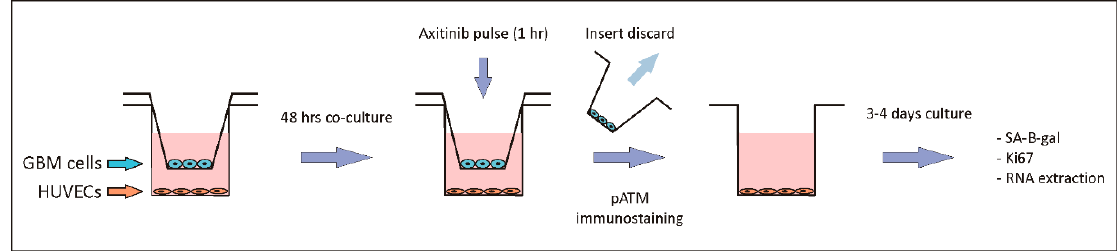
Figure 1. Schematic representation of the experimental model. The diagram summarizes the organization of the experiments performed in the paper.